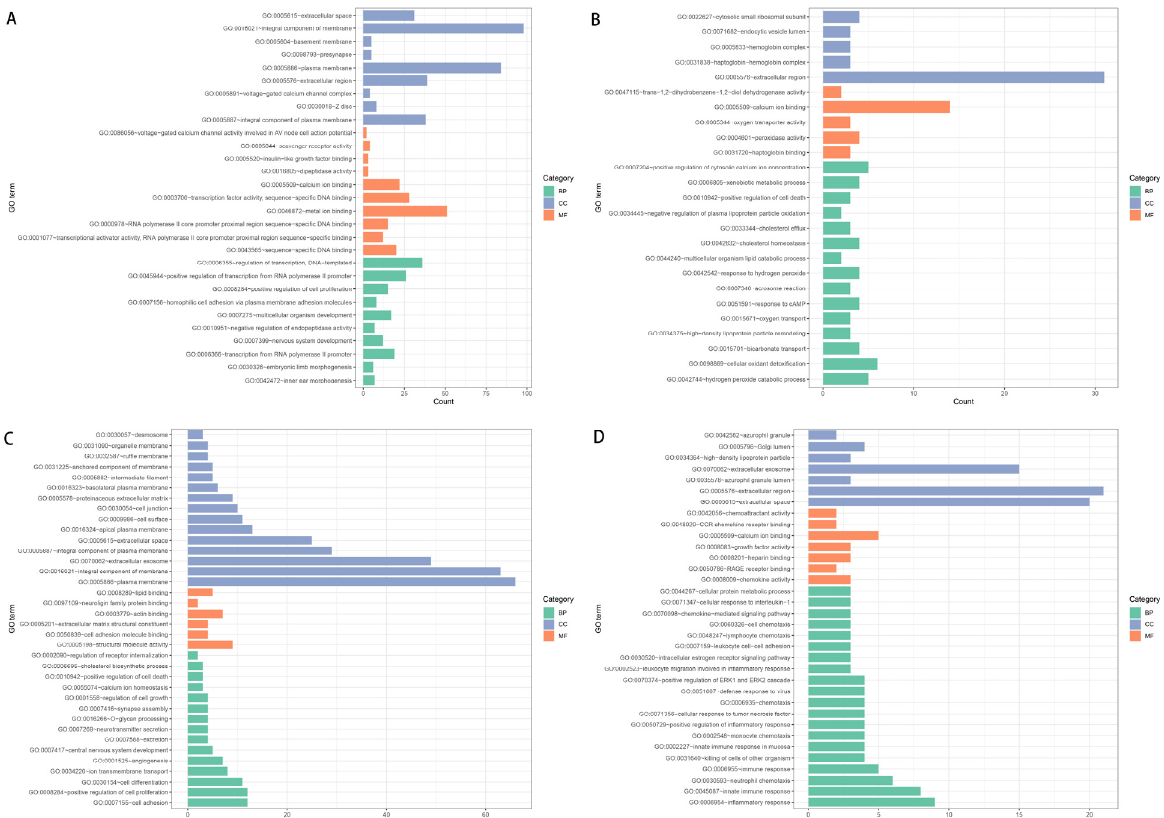
Figure 3. ( A , B ) Enrichment in Gene Ontology (GO) terms among genes in carcinoma tissues that were ( A ) upregulated or ( B ) downregulated among patients with moderate-to-severe inflammation and fibrosis relative to patients with mild inflammation and fibrosis. ( C , D ) Enrichment in GO terms among genes in para-carcinoma tissues that were ( C ) upregulated or ( D ) downregulated among patients with moderate-to-severe inflammation and fibrosis relative to patients with mild inflammation and fibrosis.